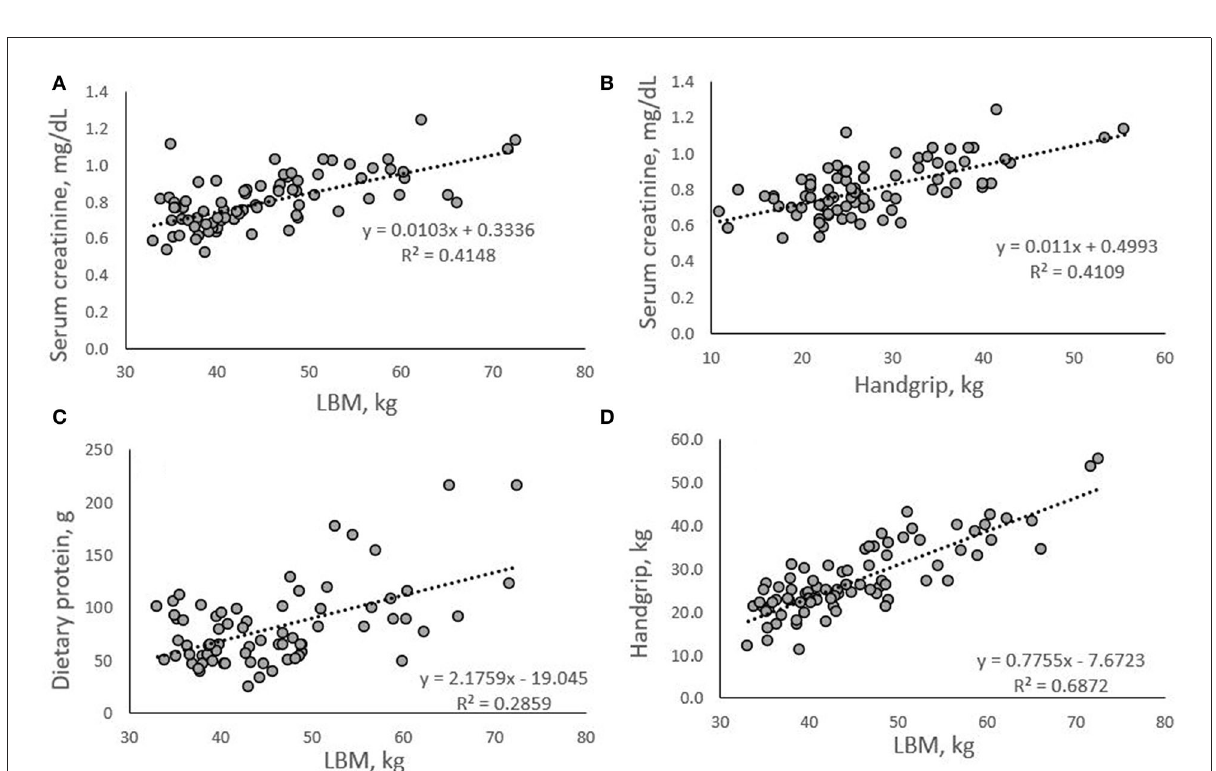
FIGURE1 Correlations between serum creatinine, LBM (A) , and handgrip (B) ; dietary protein and LBM (C) ; and handgrip and LBM (D) . All correlations were significant ( p < 0.001).